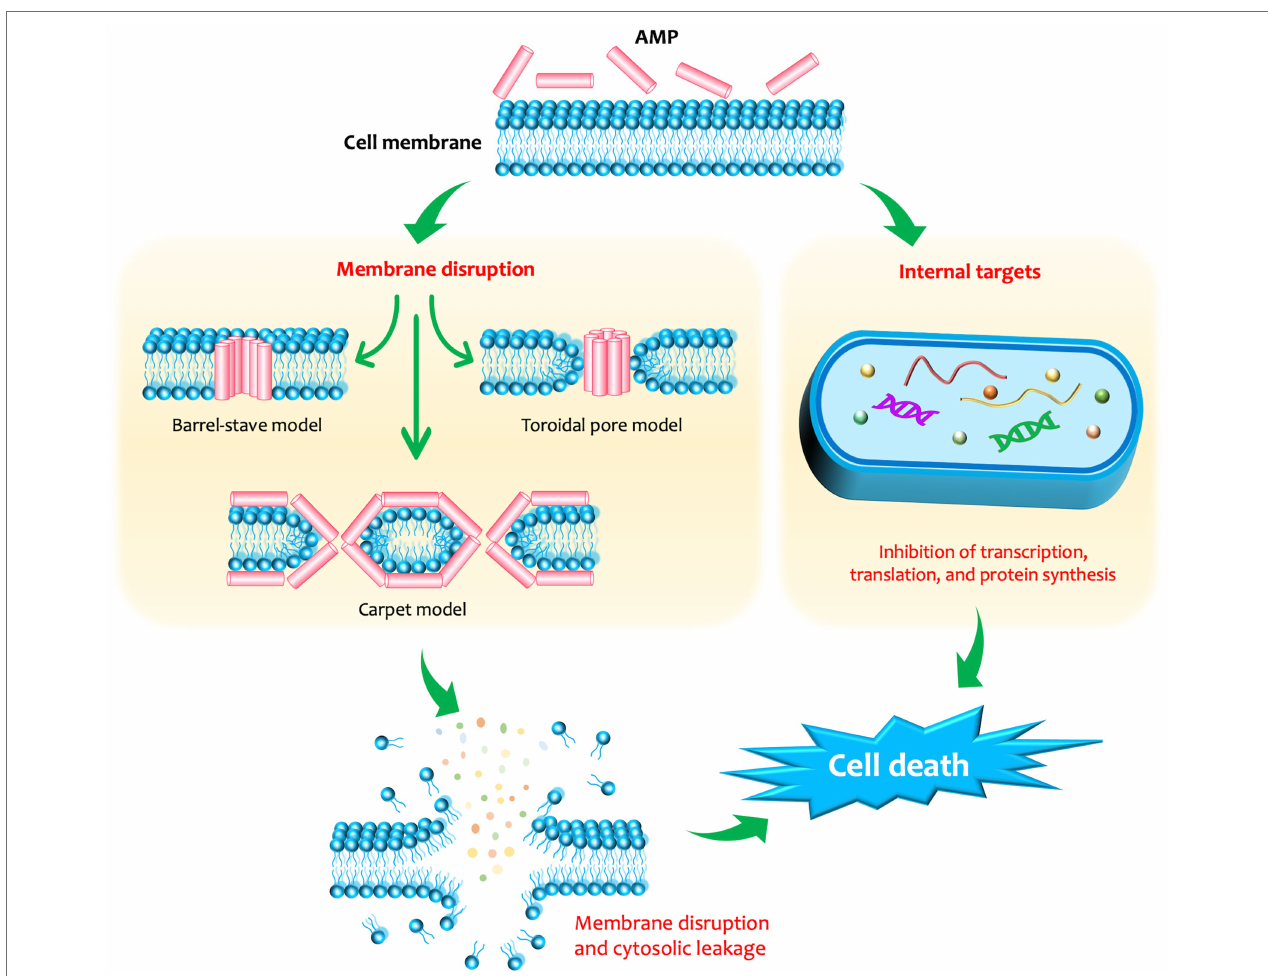
FIGURE 1 | The membrane-disruptive and non-membrane-disruptive antibacterial mechanisms of antimicrobial peptides (AMPs). In the membrane-disruptive mechanisms, three types of interaction can occur between the membrane and the AMPs, including: (i) barrel-stave model: the peptide monomers form a hydrophilic transmembrane channel by arranging parallelly to the phospholipids of the membrane; (ii) carpet model: the peptides solubilize the membrane into micellar structures; and (iii) toroidal model: the lipid moieties fold inward due to the cascade aggregation of peptide monomers, forming a peptide-and-lipid-lined